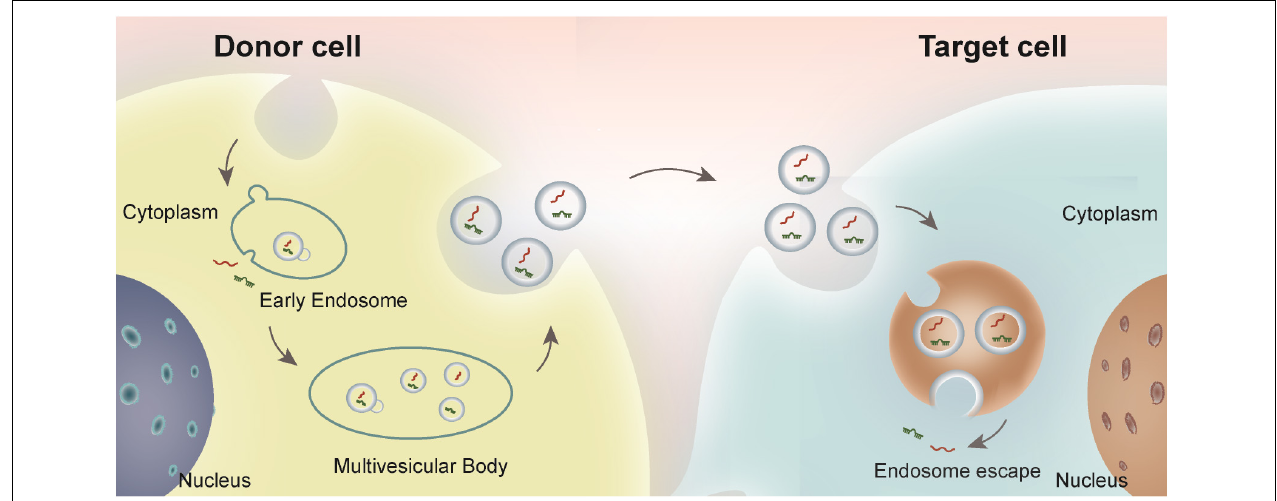
FIGURE 1 | Schematic illustration of exosome biogenesis and intercellular communication. Exosomes, originated from the endosome in the donor cells, are secreted and endocytosed by the recipient cells either adjacent to or distal from the donor cells. The bioactive cargos could be escaped from the endosome in the recipient cells and play functional